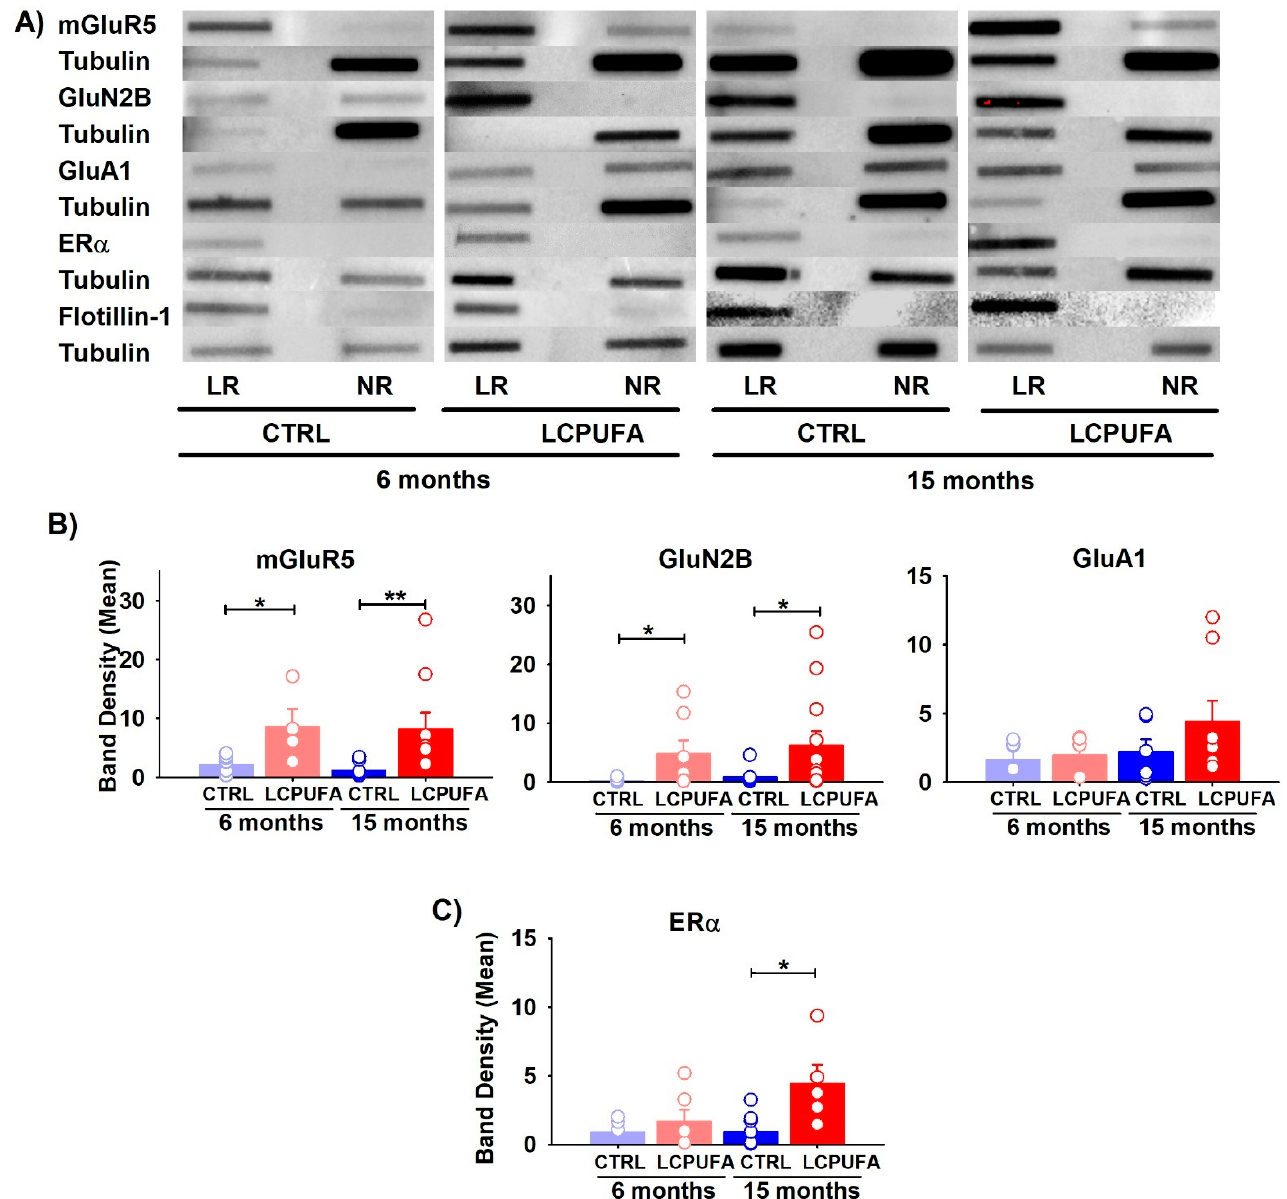
Figure 2. Differential expression of receptors in lipid raft fractions of the hippocampus. ( A ) Repre- sentative bands obtained by slot blot technique are shown for each condition. Tubulin expression was used as the charge control and flotillin-1 as the control from lipid raft fractions. In all cases, lipid raft fraction (LR) and non-raft fraction (NR) are shown. ( B ) Effect of age and diet on glutamatergic receptors expression. ( C ) Effect of age and diet on ER α expression. Bars represent the means of band density ± SEM of 4–12 mice per group (bands: mGluR5 6 m n = 7 and 15 m n = 9; GluN2B 6 m n = 8 and 15 m n = 12; GluA1 6 m n = 5 and 15 m n = 8; Er α 6 m n = 6 and 15 m n = 7). Circles represent each individual measurement. Data were analyzed by a 2-way ANOVA (diet, age) and Tukey’s post hoc test (* p < 0.05, ** p < 0.01). Data analysis was performed after normalization of the normalization of band intensity relative to tubulin.